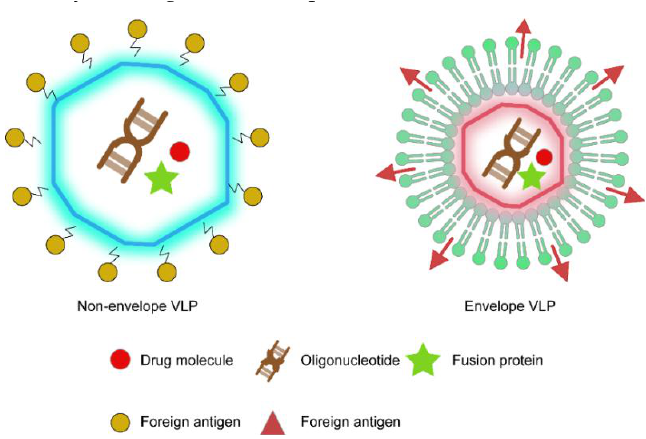
Figure 2. Non-enveloped and enveloped VLPs as a platform for antigen presentation and cargo delivery. The internal cavity of the VLPs accommodates exogenous oligonucleotides (rendered as brown gene-like patches), drug molecules (red circle), and small proteins (green pentagram) that can be delivered after the VLPs get the target organs or cells. The outer surface of the VLPs displays foreign proteins that are fused (red triangle) or covalently conjugated (yellow-green circle) to the